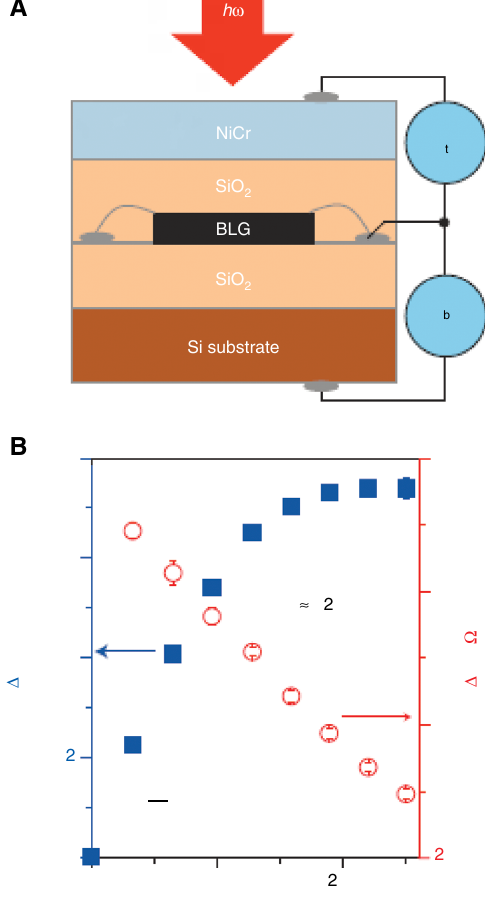
Figure 10 Dual-gated bilayer graphene hot electron bolometer. (A) Sketch of the dual gated bilayer graphene hot electron bolom- eter device. (B) Photoresponse of the device. The device is at charge neutral point and the displacement field is 0.45 V/nm. Blue squares are the changes in the voltage and red dots are the photon-induced resistance change and x -axis is the DC current passing through the device (A–B reprinted with permission from [33], Copyright 2012 Nature Publishing Group).